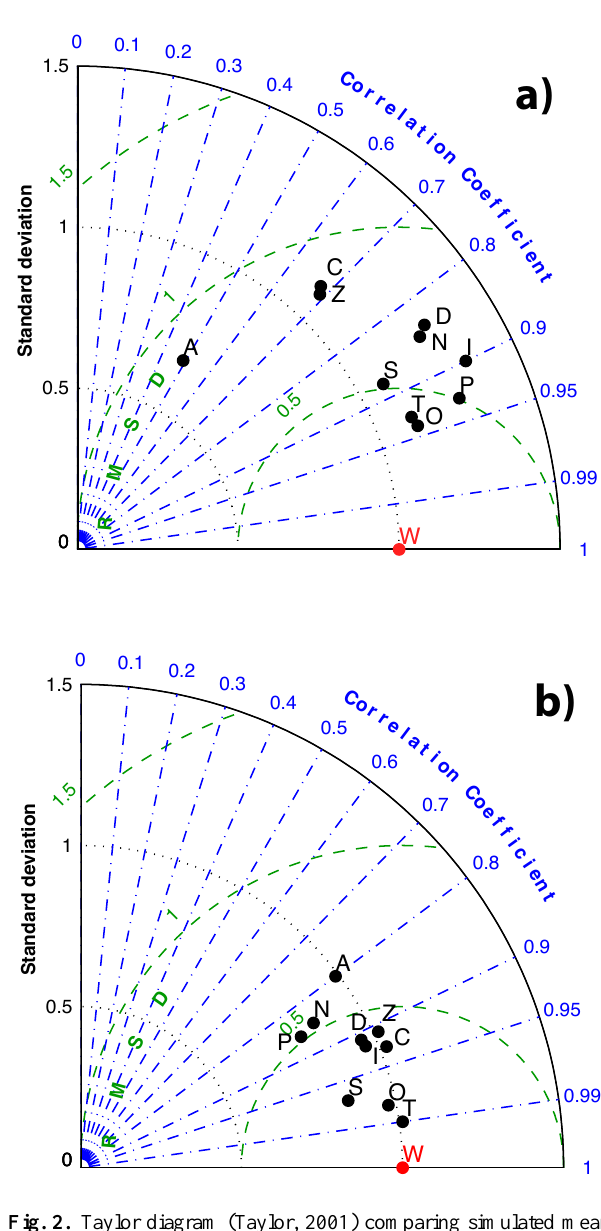
Fig. 2. Taylor diagram (Taylor, 2001) comparing simulated mean (1978–2007) and observed fields (a) for the entire ocean weighted by volume, (b) for the surface weighted by area. T – potential tem- perature, S – salinity, P – phosphate, N – nitrate, I – silicate, O – oxygen, D – DIC, A – Alkalinity, C – CFC11, Z – CFC12, the red W and dot denote the observations. Climatologies for temperature, salinity, phosphate, nitrate, silicate and oxygen are from WOA05 (Boyer et al., 2006), those for DIC, Alkalinity, CFC11 and CFC12 from GLODAP (Sabine et al., 2005). Standard deviations were nor- malised to combine the different variables in one diagram. The Tay- lor diagram provides a concise statistical summary of how well the simulated tracer distributions match the observed ones in terms of their correlation (the azimuthal position on the diagram), their rel- ative standard deviations (the radial distance), and their root-mean- square difference (the green dashed circles). The observations are placed at the point on the diagram where both correlation and stan- dard deviation are